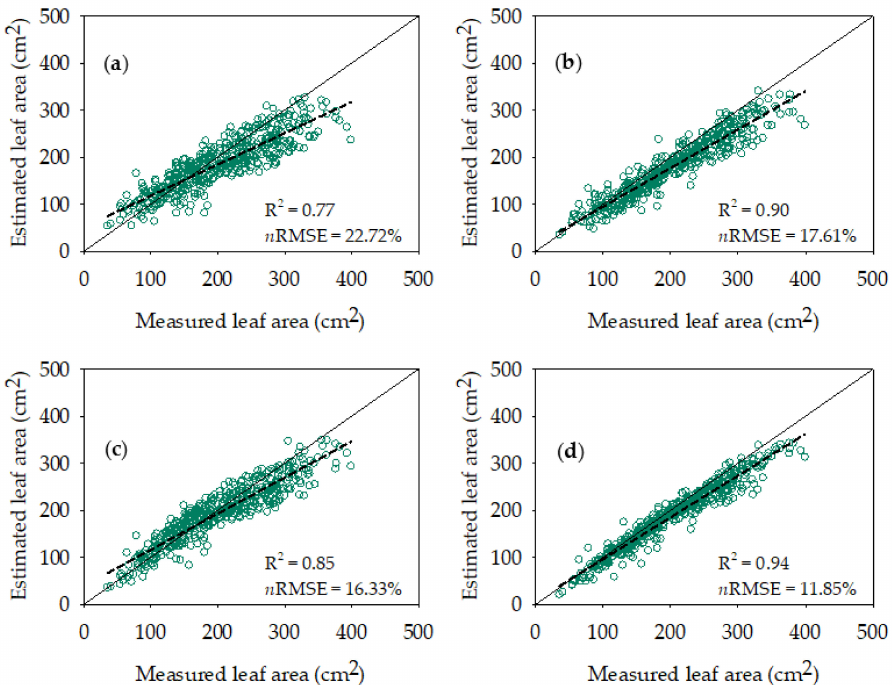
Figure 6. Estimated individual leaf area (cm 2 ) and measured individual leaf area (cm 2 ) using the function LA = 19.61L − 157.83 ( a ), LA = 3.68 L + 2.35K − 51.31 ( b ), LA = 8.92L + 1.18J − 99.29 ( c ), and LA = − 3.39L + 2.04K + 1.01J − 15.10 ( d ) for cassava leaves of the Kasetsart 50 and CMR38–125–77 genotypes and 18 segregating progenies ( n = 474), n RMSE = normalized root mean square error.